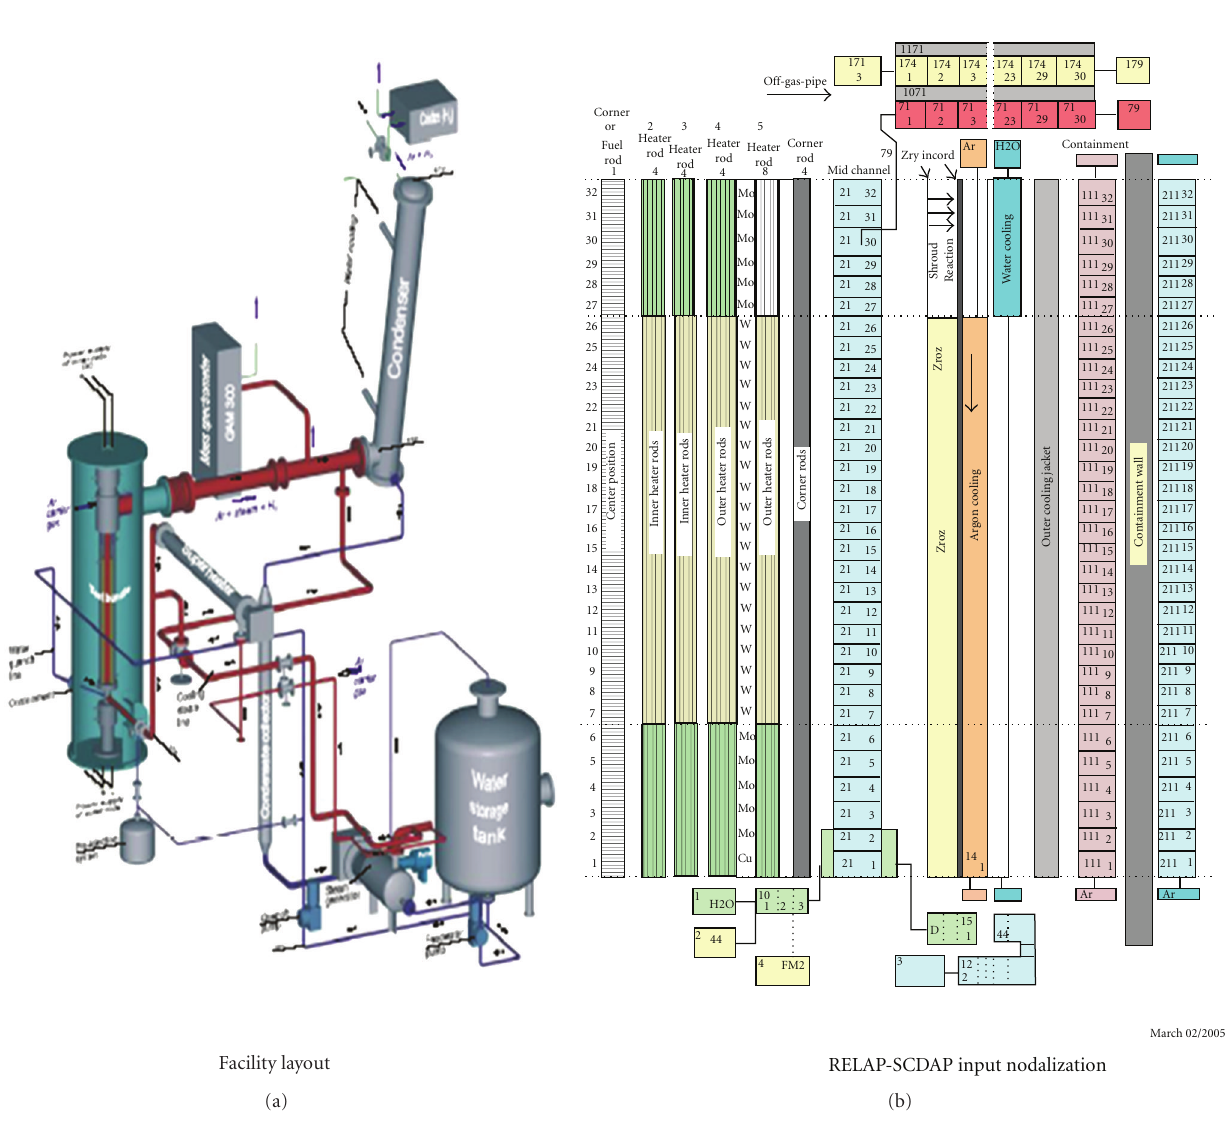
Figure 21: Example of experiment design—quench facility layout and input